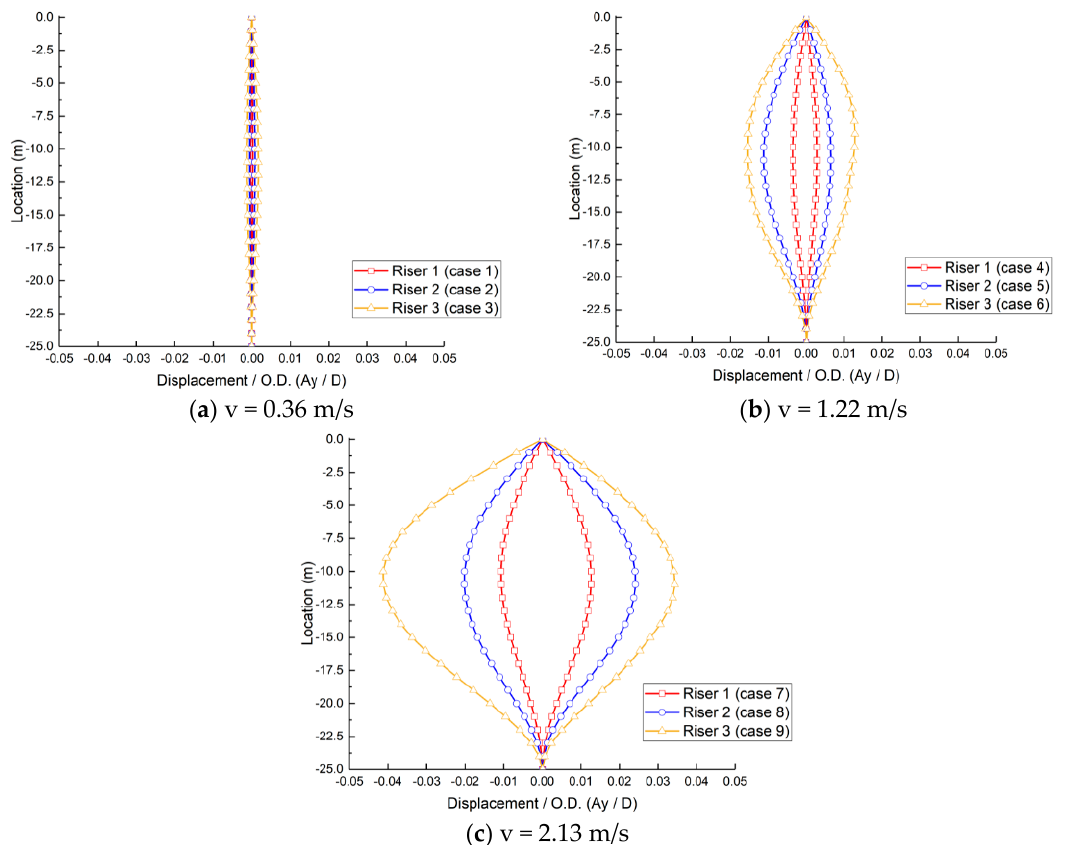
Figure 9. Maximum displacements cross flow direction (Y) of all three risers.